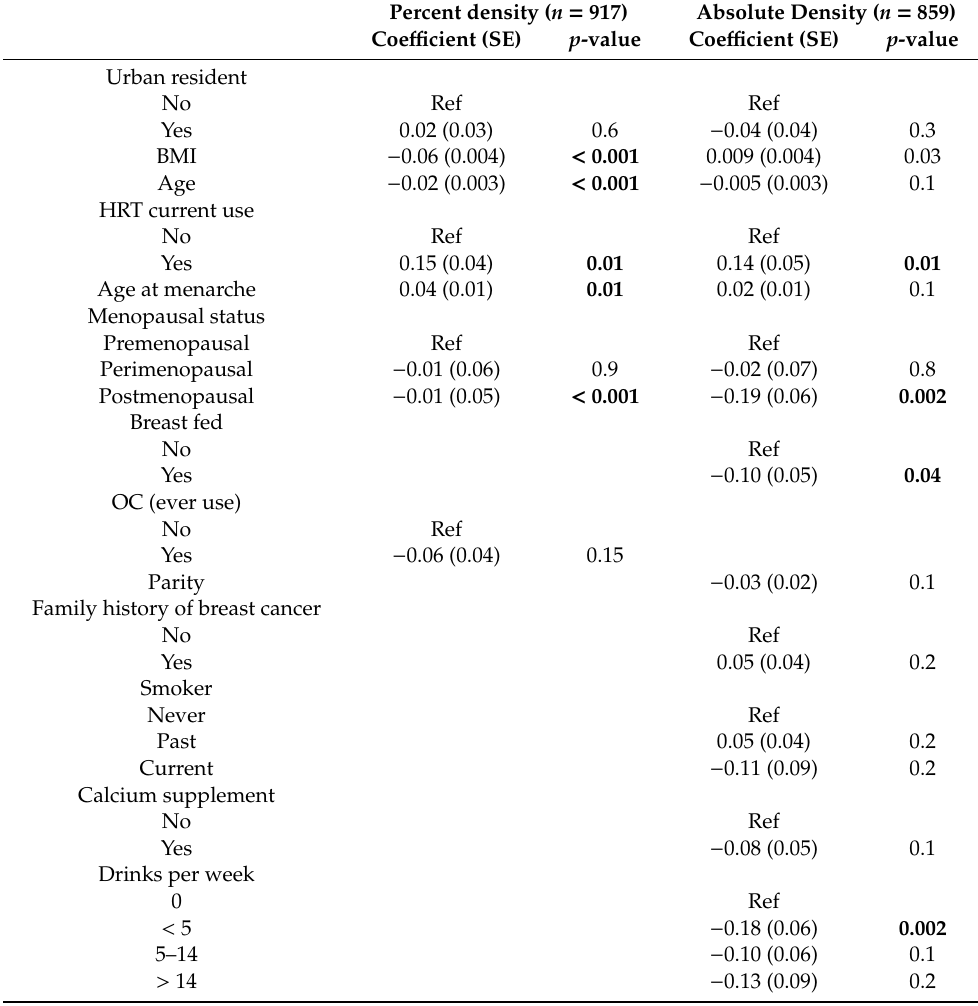
Table 2. Results of multiple regression analysis including urban residence; only coe ffi cients for those variables included in the final model are